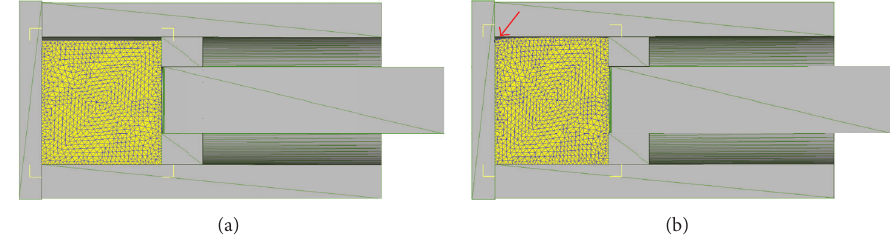
Figure 6: Mesh graph of billet (a) before and (b) after upsetting process.